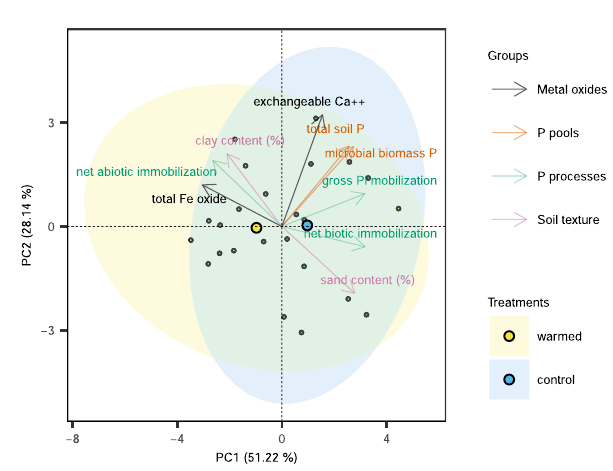
Fig. 2 | Principal componentanalysis(PCA). PCA wasconductedwithtotalsoilP, microbialbiomassP, exchangeableCa ++ , totalFe oxide, netabioticimmobilization, netbioticimmobilization,grossP i mobilization,sandcontent(%),andclaycontent (%), with vectors displaying the association of these factors with principal com- ponent (PC) 1 and PC2. Individual cases are grouped by treatment, and large dots indicate the mean points of each group. Arrows represent loadings of variables. Positively correlated variables are grouped together, while negatively correlated variables arepositioned onopposite sides of the plotorigin.The distancebetween variables and the plot origin measures their importance on the respective